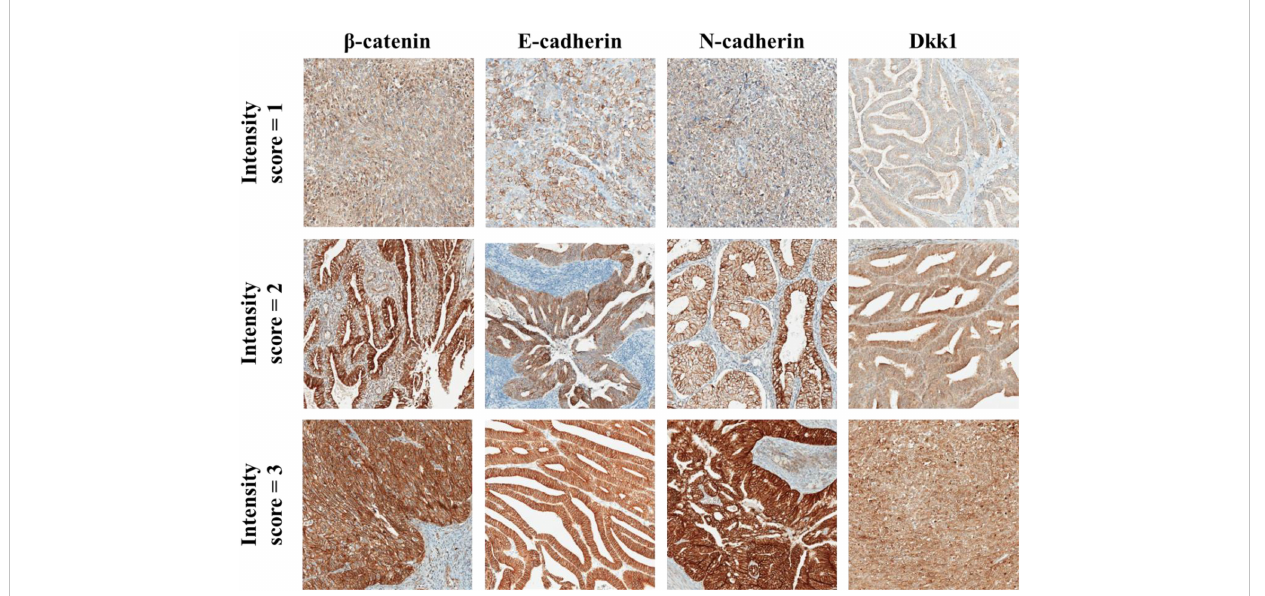
FIGURE 1 Examples of IHC staining for b -catenin, E-cadherin, N-cadherin, and Dkk1 in EC tumour cells. Staining interpretation was done by assessing staining intensity as weak (intensity score = 1), moderate (intensity score = 2) and strong (intensity score = 3). Intensity score was multiplied by the % of tumour cells with positive reaction and the result was recorded as H score (range from 0 to 300). All micrographs are taken at 100x magni fi